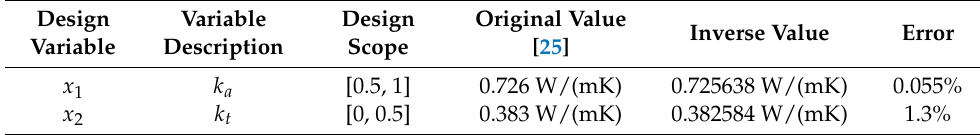
Table 1. Design variables and design